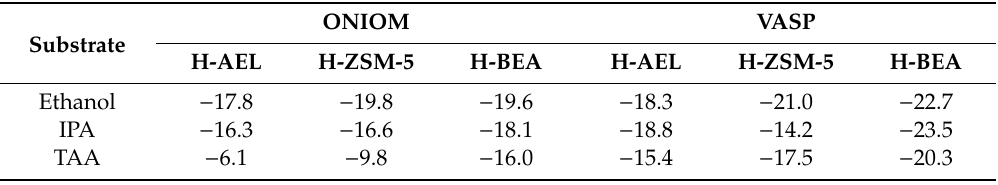
Table 3. Calculated adsorption energies (kcal mol − 1 ) of alcohols in H-AEL, H-ZSM-5, and H-BEA using